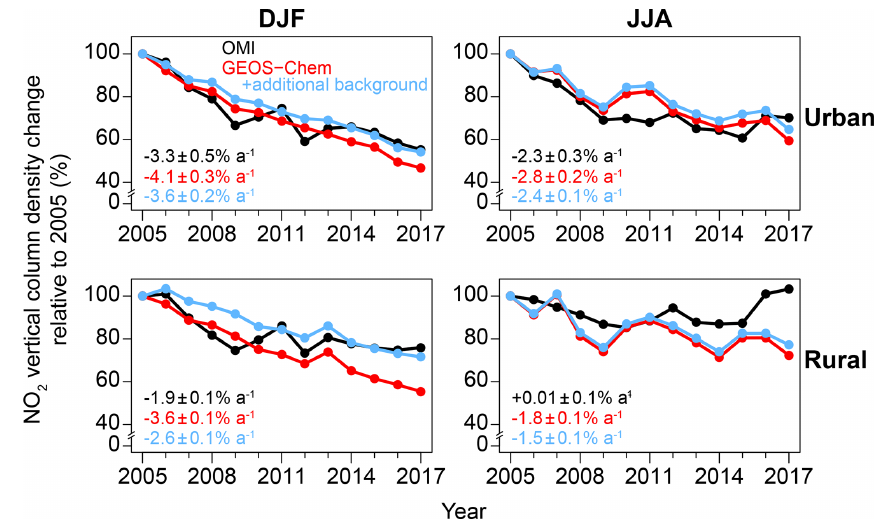
Figure 5. OMI tropospheric NO 2 column trends over the contiguous US relative to 2005, separated into urban and rural as well as summer (JJA) and winter (DJF). OMI observations are shown in black, the standard GEOS-Chem model simulation with EPA National Emission Inventory (NEI) trends (EPA, 2018) is in red, and the GEOS-Chem sensitivity simulation with additional NO 2 background (50ppt above 5km in winter and above 10 km in summer, up to the local tropopause) is shown in blue. Slopes and standard deviation of the linear regressions are shown inset. Urban conditions are defined as the top 10% NO x -emitting 0.5 ◦ × 0.625 ◦ grid squares in the